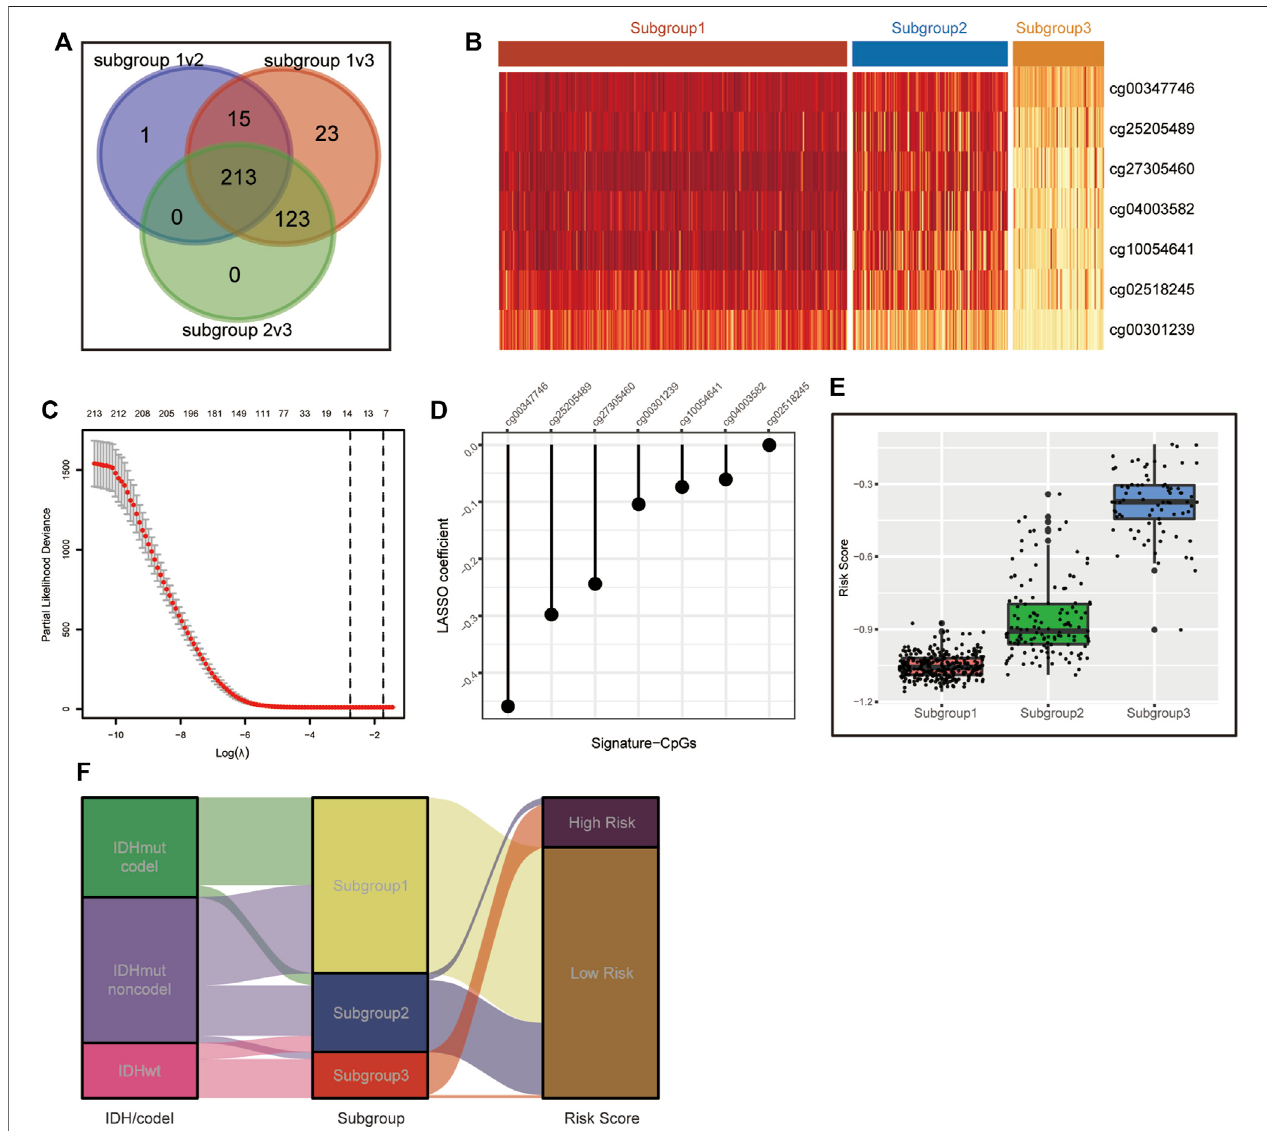
FIGURE 3 | Construction of the CpG signature. (A) Venn diagram illustrating the 213 metabolism-associated CpGs differentially methylated across all three subgroups. (B) Heatmap of beta values of the signature CpGs in the three LGG subgroups in TCGA. (C) Plot of correlation between partial likelihood deviance and lambda value in LASSO regression. Themaximum lambda value within theonestandard errorof thepartial likelihood deviance minimizer wasdetermined asthe optimal value. (D) Signature CpGs and corresponding LASSO coef fi cients. (E,F) Boxplot (E) and Sankey diagram (F) demonstrating the correlation of the CpG signature and metabolism-associated subgroups in